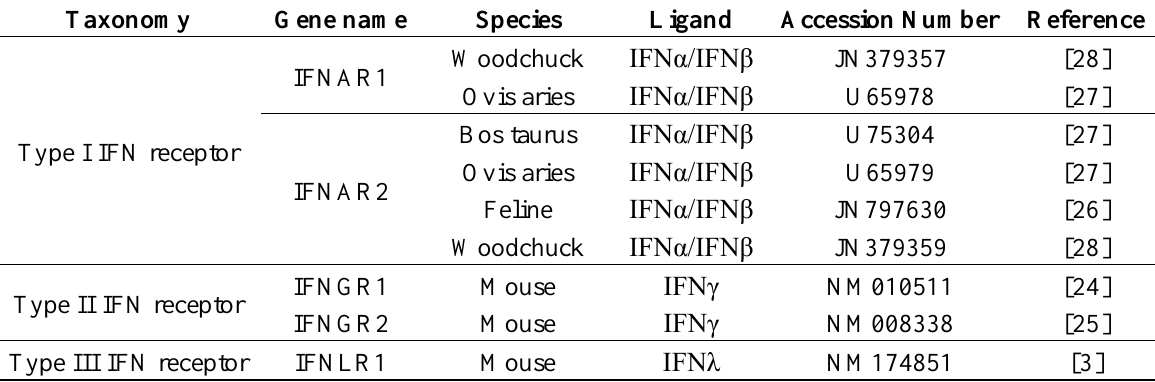
Table 2. List of the interferon receptors identified in some mammals.